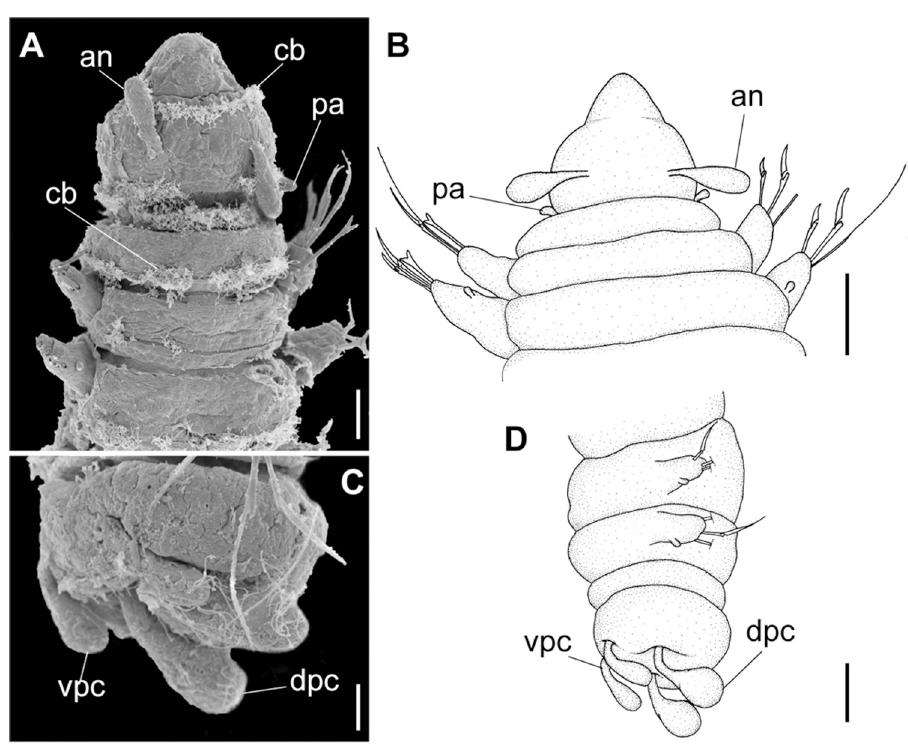
Fig 3. Meiodorvillea minuta (Hartman, 1965), ZUEL-POL. (A,B) anterior region, dorsal view; (C,D) pygidium, lateral view. Abbreviations: an = antenna; dpc = dorsal pygidial cirrus; pa = palp; vpc = ventral pygidial cirrus. Scales: (A) = 20 μ m; (B) = 25 μ m; (C) = 10 μ m; (D) = 15.6 μ m.